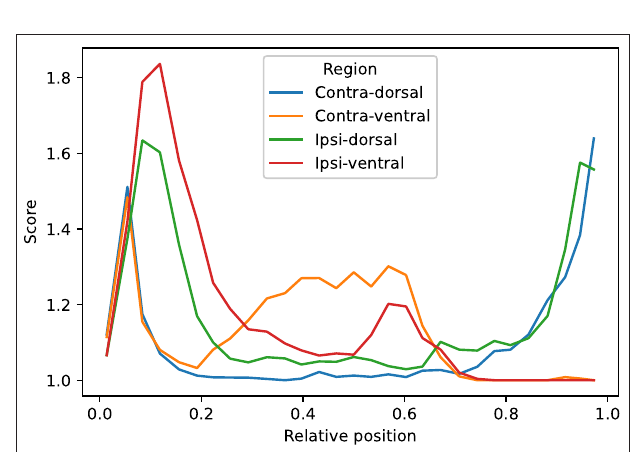
FIGURE 8 | Average qualitative scores as a function of the relative position of the slice across the hippocampus, with 0 indicating the most caudal and 1 the most rostral coronal slice. Averages were obtained by dividing the interval in 30 bins. The vast majority of inaccuracies are located in the most rostral and caudal